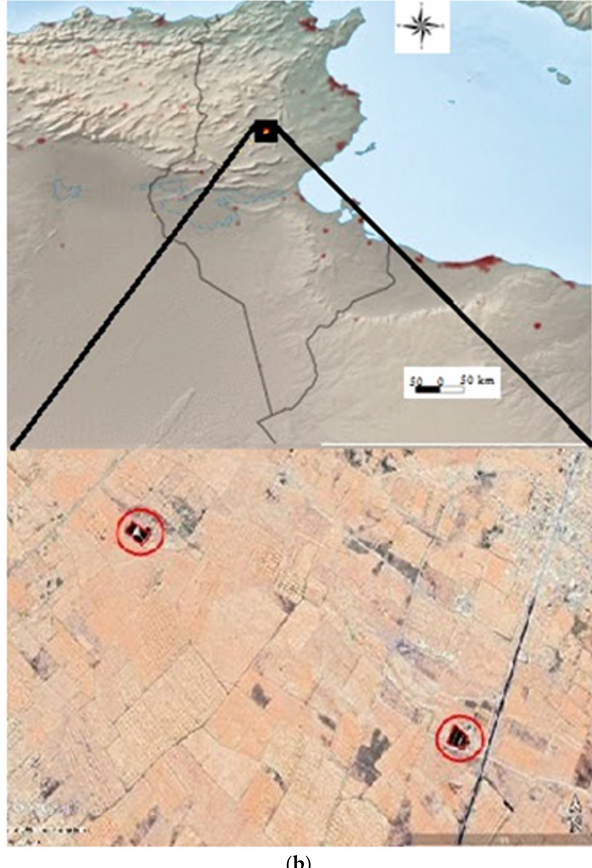
Figure 1. ( a ) Greek study areas, (red circle: OMW disposal areas), ( b ) Tunisian study areas, (red circle: OMW disposal areas).